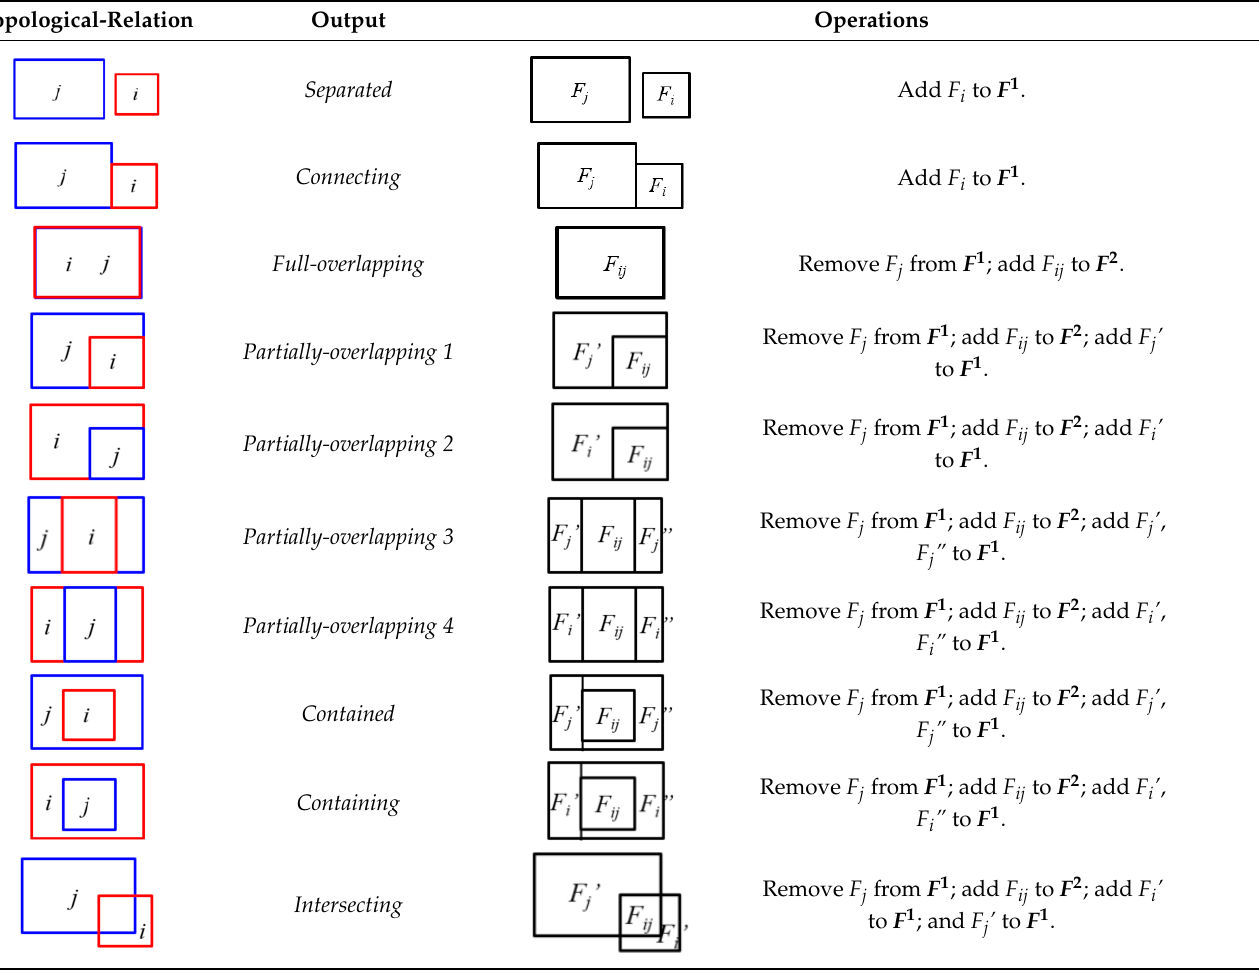
Table 3. 1D topological relations between the co-linear 3D edges and corresponding operations. Topological-Relation